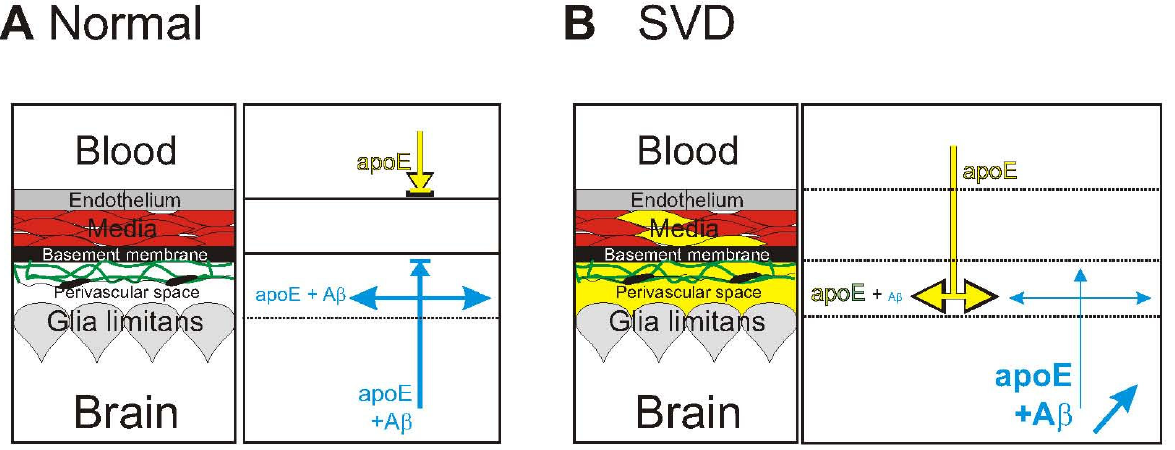
FIGURE 2. Schematic representation of the SVD-induced alteration of the precapillary segment of the BBB. (A) Physiological situation. (B) SVD-related BBB alteration. Due to endothelial lesions and the high arterial blood pressure, plasma leaks into the media of the arteries and finally into the perivascular space. Here, plasma proteins, including apoE, compete with the extracellular fluid, including brain-derived apoE and A β, for drainage. This competition leads to an insufficient clearance of brain apoE and A β , and finally to the accumulation of A β in the brain and the predominance of apoE-cleavage fragments in relation to full-length